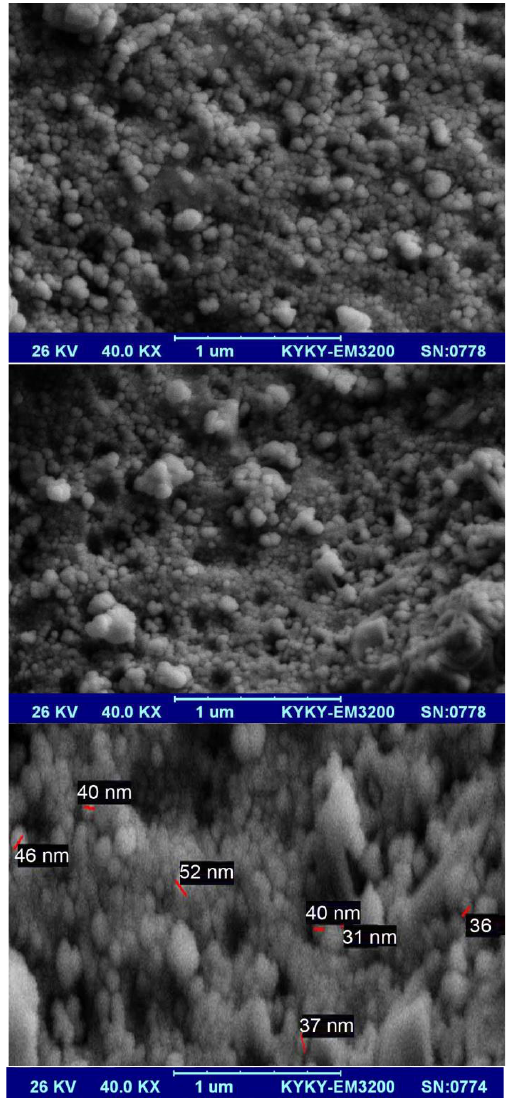
Fig. 4. SEM images of nanoparticles obtained by